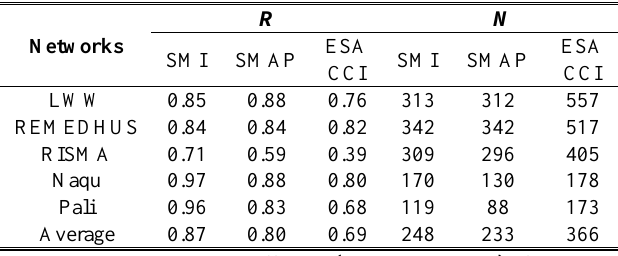
Table 2. Correlation coefficient ( R , p-value < 0.05) of SMI, SMAP and ESA CCI with ground observations from the five networks. N is the number of